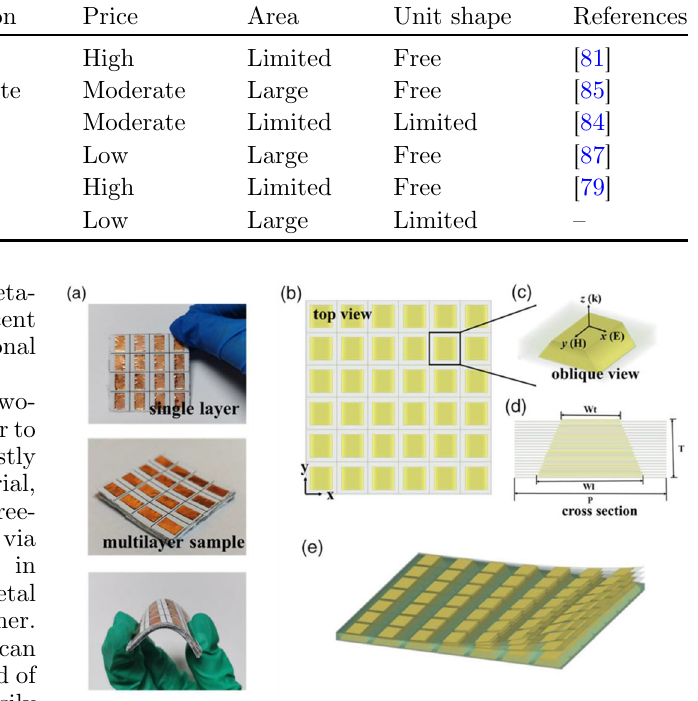
Fig. 7. Design and fabrication of the 2.5D metamaterials: (a) the structural unit was printed on a single layer of paper and stacked together, (b – e) schematic of the 2.5D design: (b) top view, (c) oblique view, (d) 2D cross-sectional view of the structure, and (e) 3D illustration of the simulated metamaterials [91]. Reproduced with permission from X. Fu et al., Adv. Eng.